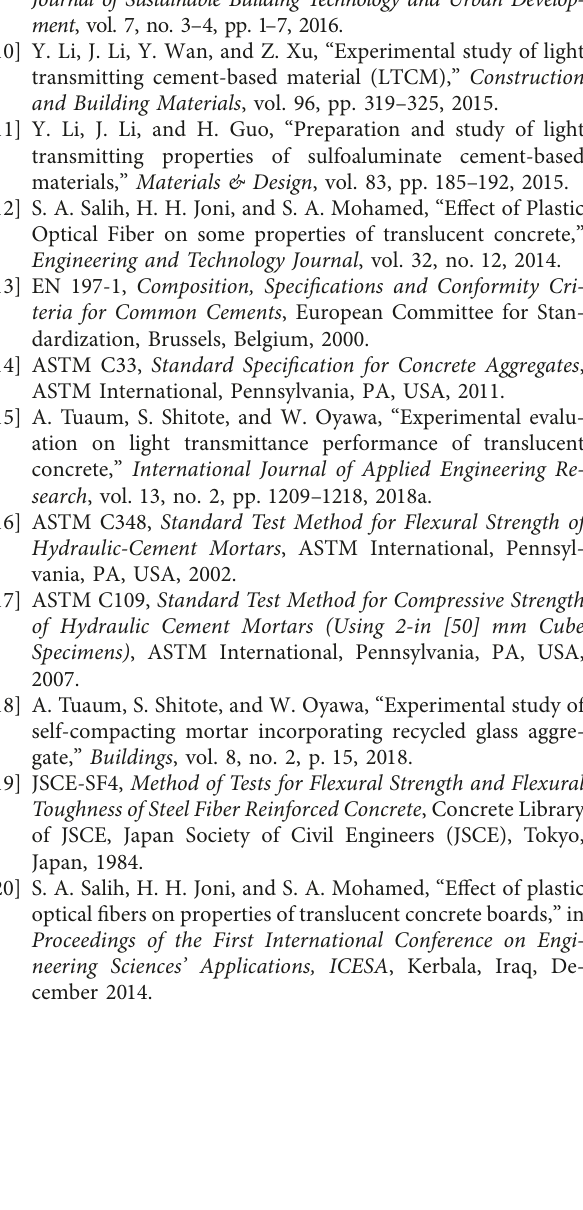
Figure 1: setup detail for structural performance of the translucent concrete panel. Figure 2: JSCE-SF4 flexural toughness and toughness factor definition. Figure 3: normal stress profile of the structural panel/façade. Figure 4: shear stress profile of the structural panel/façade. Supplementary Table 1: POF computation for translucent concrete speci- mens (compressive strength test cubes (Ø2 mm POF)). Supplementary Table 2: POF computation for translucent concrete specimens (compressive strength test cubes (Ø3 mm POF)). Supplementary Table 3: POF computation for translucent concrete specimens (flexural strength test cubes (Ø2 mm POF)). Supplementary Table 4: POF com- putation for translucent concrete specimens (flexural strength test cubes (Ø3 mm POF)). Supplementary Table 5: POF computation for the translucent concrete panel (6%v/ v). Supplementary Table 6: experimental load analysis of the reference concrete panel. Supplementary Table 7: experi- mental load analysis of the translucent concrete panel (Ø2 mm, 6% POF). Supplementary Table 8: experimental load analysis of the translucent concrete panel (Ø3 mm, 6% POF). Supplementary Table 9: flexural toughness of the reference concrete panel. Supplementary Table 10: flexural toughness of the translucent concrete panel (Ø2 mm, 6% POF). Supplementary Table 11: flexural toughness of the translucent concrete panel (Ø3 mm, 6% POF). ( Supple- mentary Materials